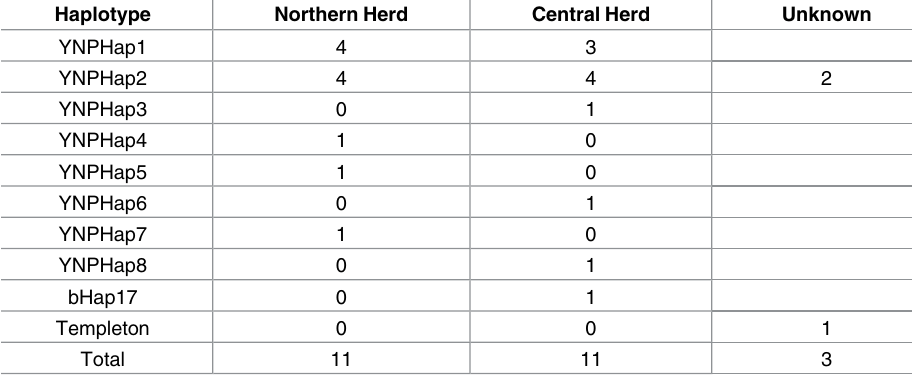
Table 1. Mitochondrial haplotype distribution in 25 bison associatedwith the northern or central herds in Yellowstone NP. Haplotype Northern Herd Central Herd Unknown YNPHap1 4 3 YNPHap2 4 4 2 YNPHap3 0 1 YNPHap4 1 0 YNPHap5 0 0 YNPHap8 0 1 bHap17 0 1 Templeton 0 0 Total 11 11